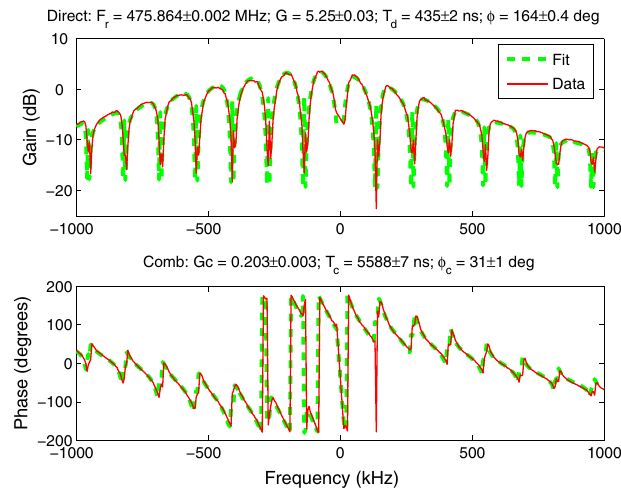
FIG. 4. (Color) Transfer function and parameters of macrosta- tion from nonlinear simulation in the LER at 1400